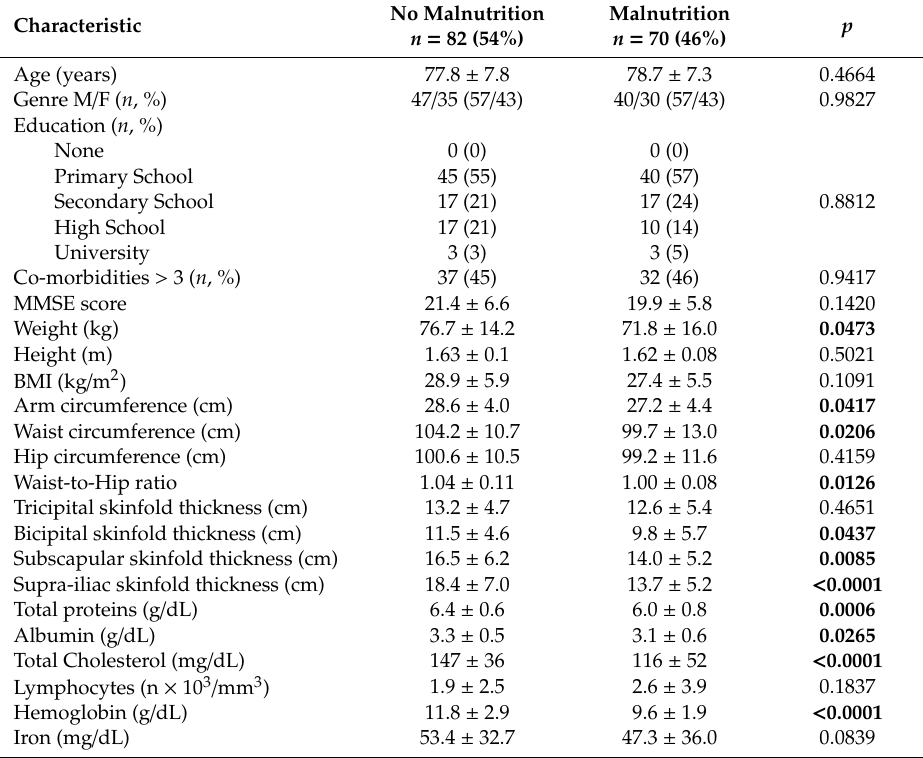
Table 1. Baseline demographic, clinical, anthropometric, and biochemical characteristics of patients, stratified according to the Global Leadership Initiative on Malnutrition